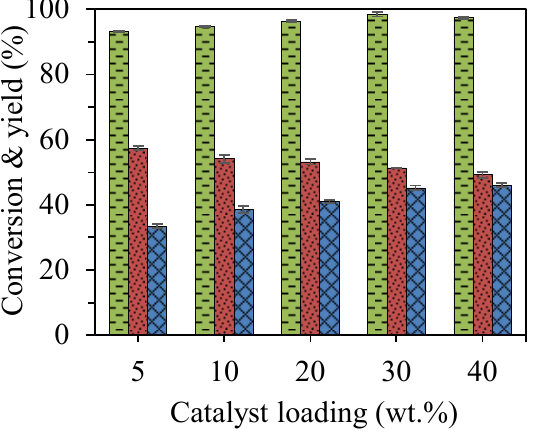
Figure 7. Effect of amount of 10-Nb/MCS catalyst loading on glucose conversion, HMF yield and humins yield. (Reaction conditions: glucose concentration, 0.07 M; solvent volume (1:2 v / v water saturated with NaCl: THF), 30 mL; temperature, 190 °C; time, 1 h; N 2 pressure, 10 bar).